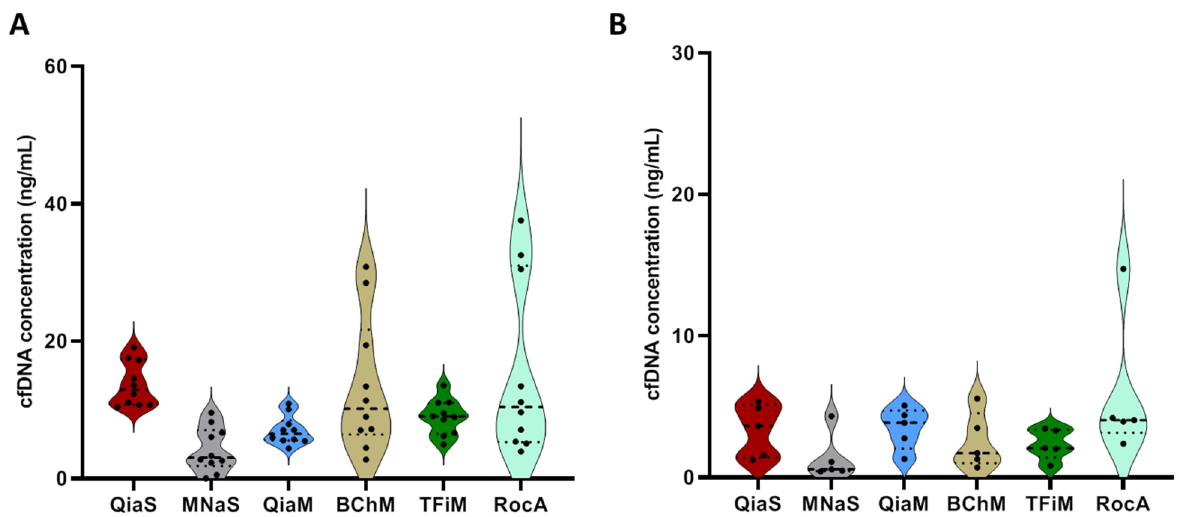
Figure 1. Comparison of cell-free DNA (cfDNA) yields delivered by different DNA extraction kits. CfDNA was isolated from the plasma of 10 healthy donors using different extraction kits and then quantified by ( A ) the Qubit HS DNA kit and ( B ) the Agilent HS DNA Kit on the Bioanalyzer. Quantitative measurements of cfDNA are expressed as the total mass of cfDNA (ng) present in 1 mL of plasma.